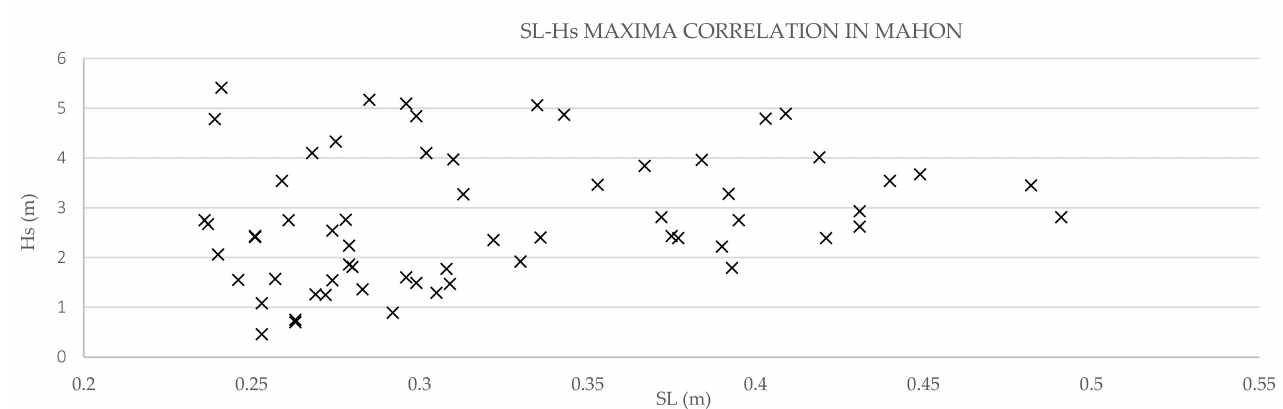
Figure 42. Correlation of extremes in Valencia.